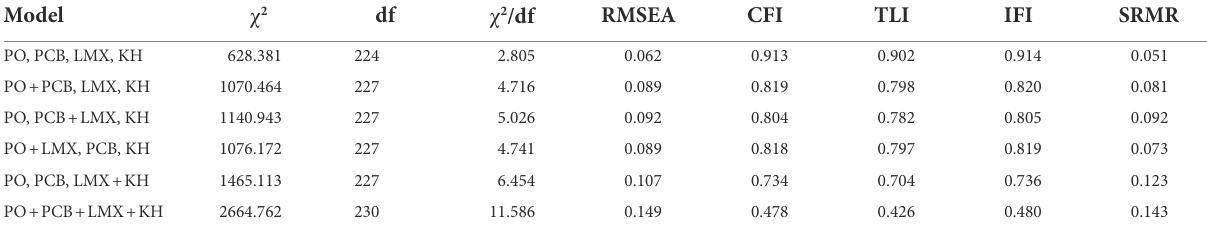
TABLE 2 Results of confirmatory factor analysis.